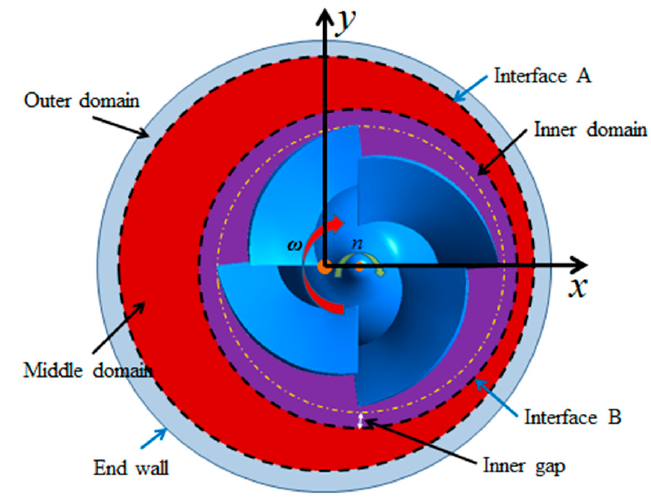
Figure 3. Schematic diagram of dynamic sliding multi-region method. Since the tip clearance of the mixed-flow pump is 0.8 mm, the water area clearance in the inner area under the 0.3 mm eccentricity parameter is set to 0.1 mm. The water area clearance in the inner area under the 0.5 mm eccentricity parameter is set to 0.3 mm. Under the two eccentricity parameters, the minimum gap between the middle and outer areas is set to 0.1 mm, as shown in Figure